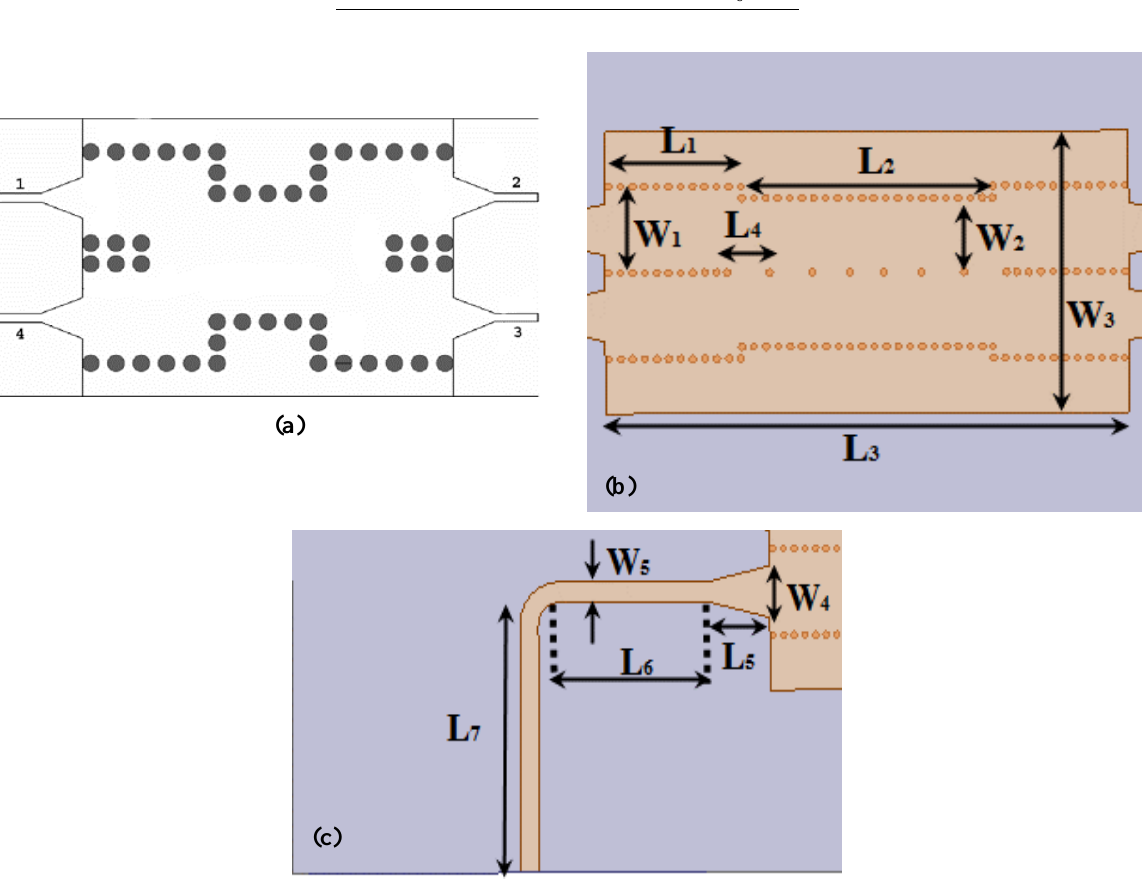
Figure 2. Geometry of the coupler (a) primary SIW coupler (b) the prototype SIW coupler (c) the final prototype